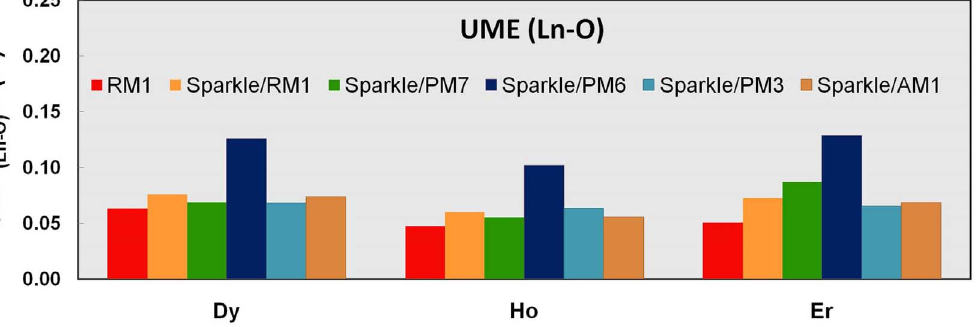
Figure 2. UME (Ln-O) s obtained using the RM1 model for the lanthanides and all five versions of the Sparkle Model: Sparkle/RM1, Sparkle/PM7, Sparkle/PM6, Sparkle/PM3 and Sparkle/AM1 for all complexes of the universe set for each of the lanthanide trications: Dy(III), Ho(III) and Er(III). The UMEs are calculated as the absolute value of the difference between the experimental and calculated Ln- O interatomic distances, summed up for all complexes, for each of the